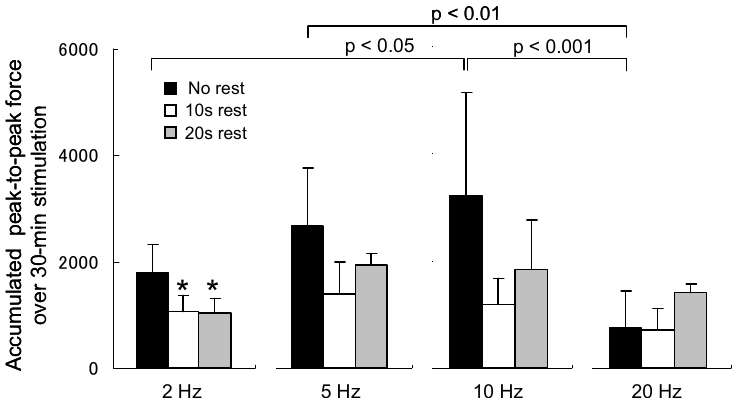
Fig. 8 Comparison of peak-to-peak contraction forces accumulated over the 30 min among all the combinations of stimulation frequency and resting time. Each peak-to-peak force was normalized to the 1st peak force before the accumulation. Symbols: *p < 0.05 vs. no-rest group in the same frequency.